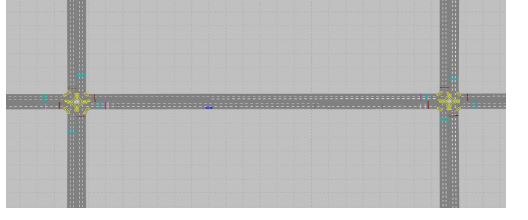
Fig 7. Simulation network of coordinated intersections.